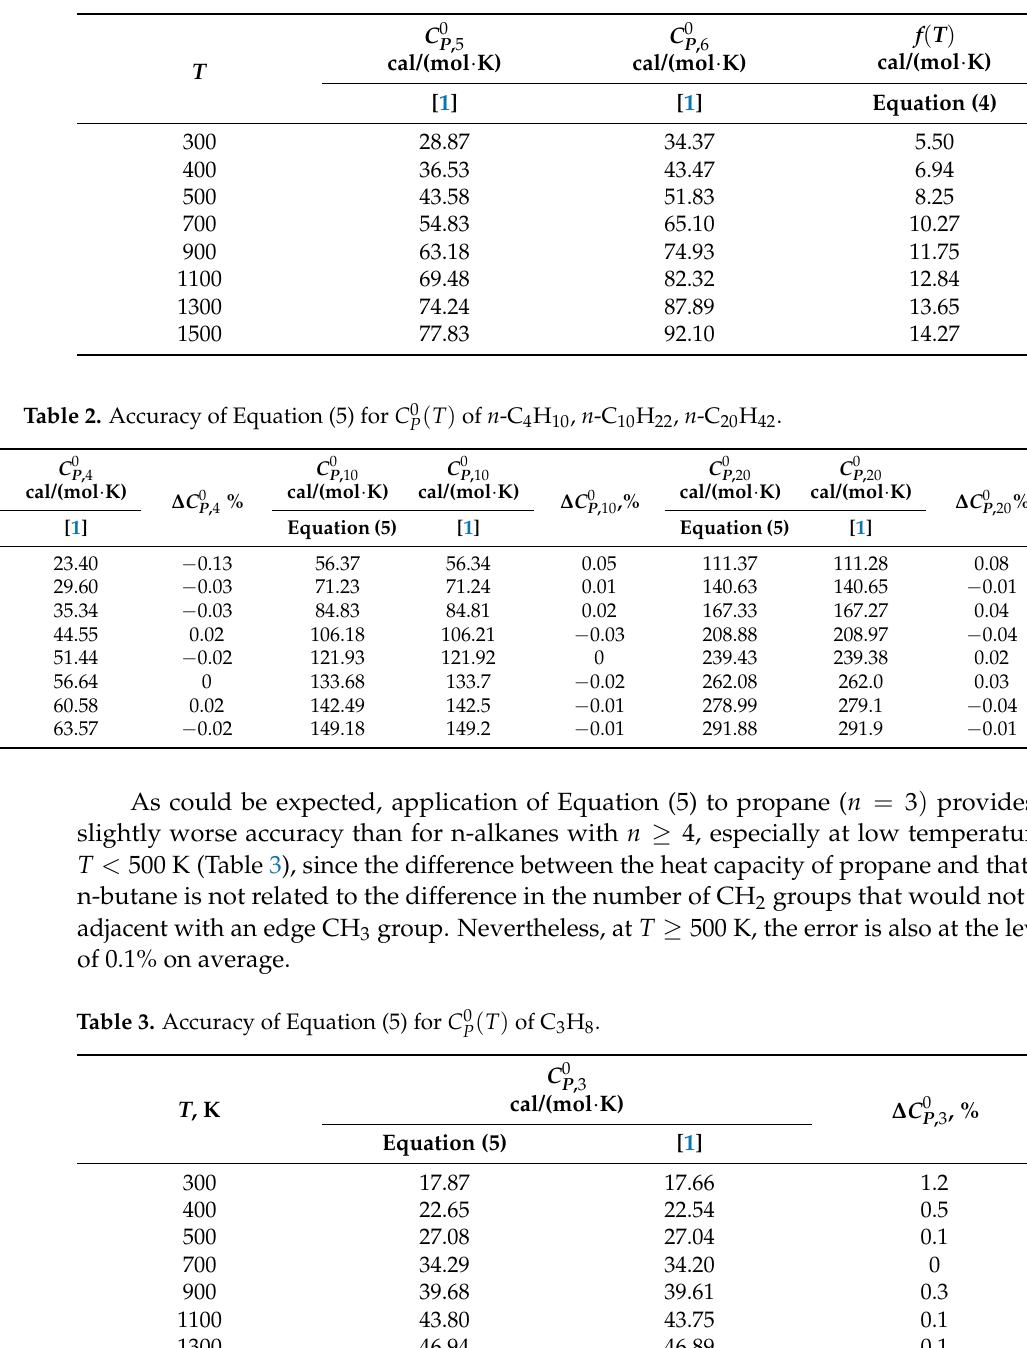
Table 1. Function f ( T ) in Equation (4).